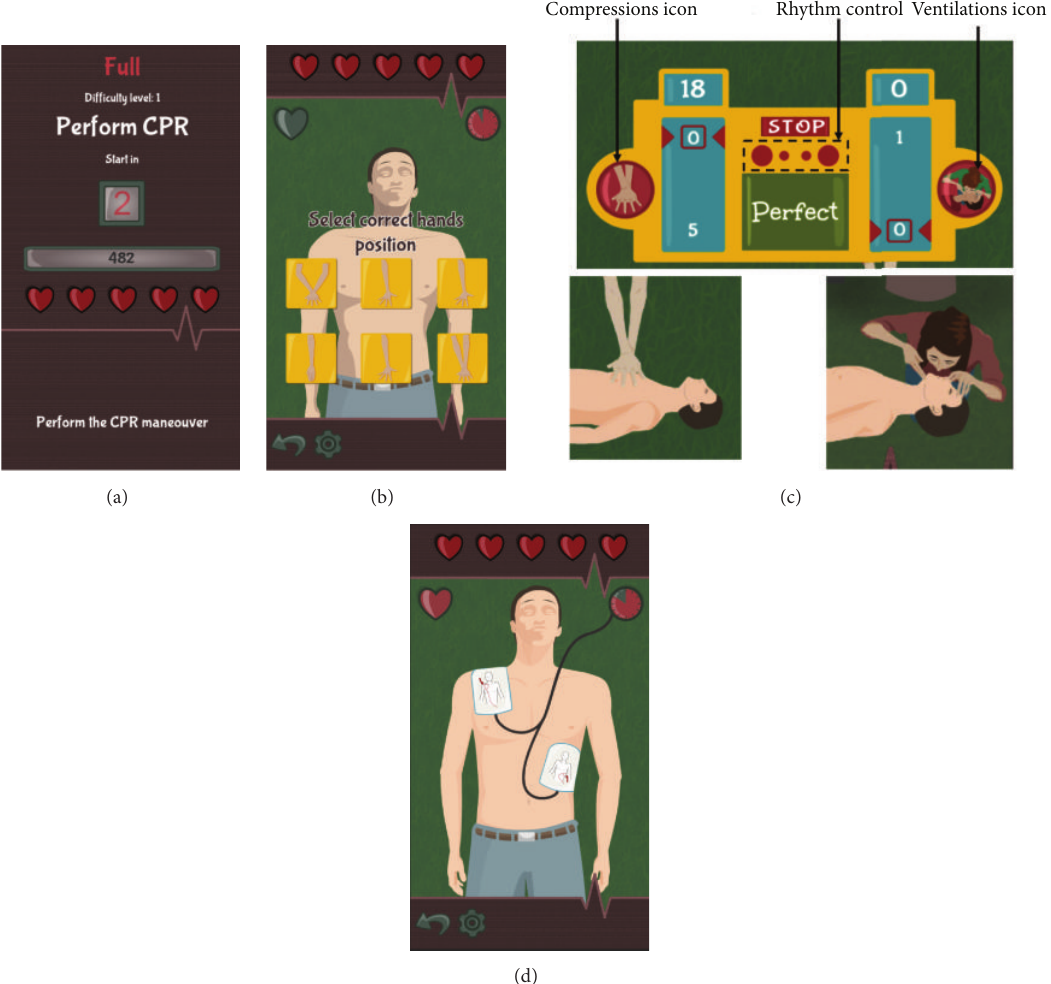
Figure 11 corresponds to the Security Position mini